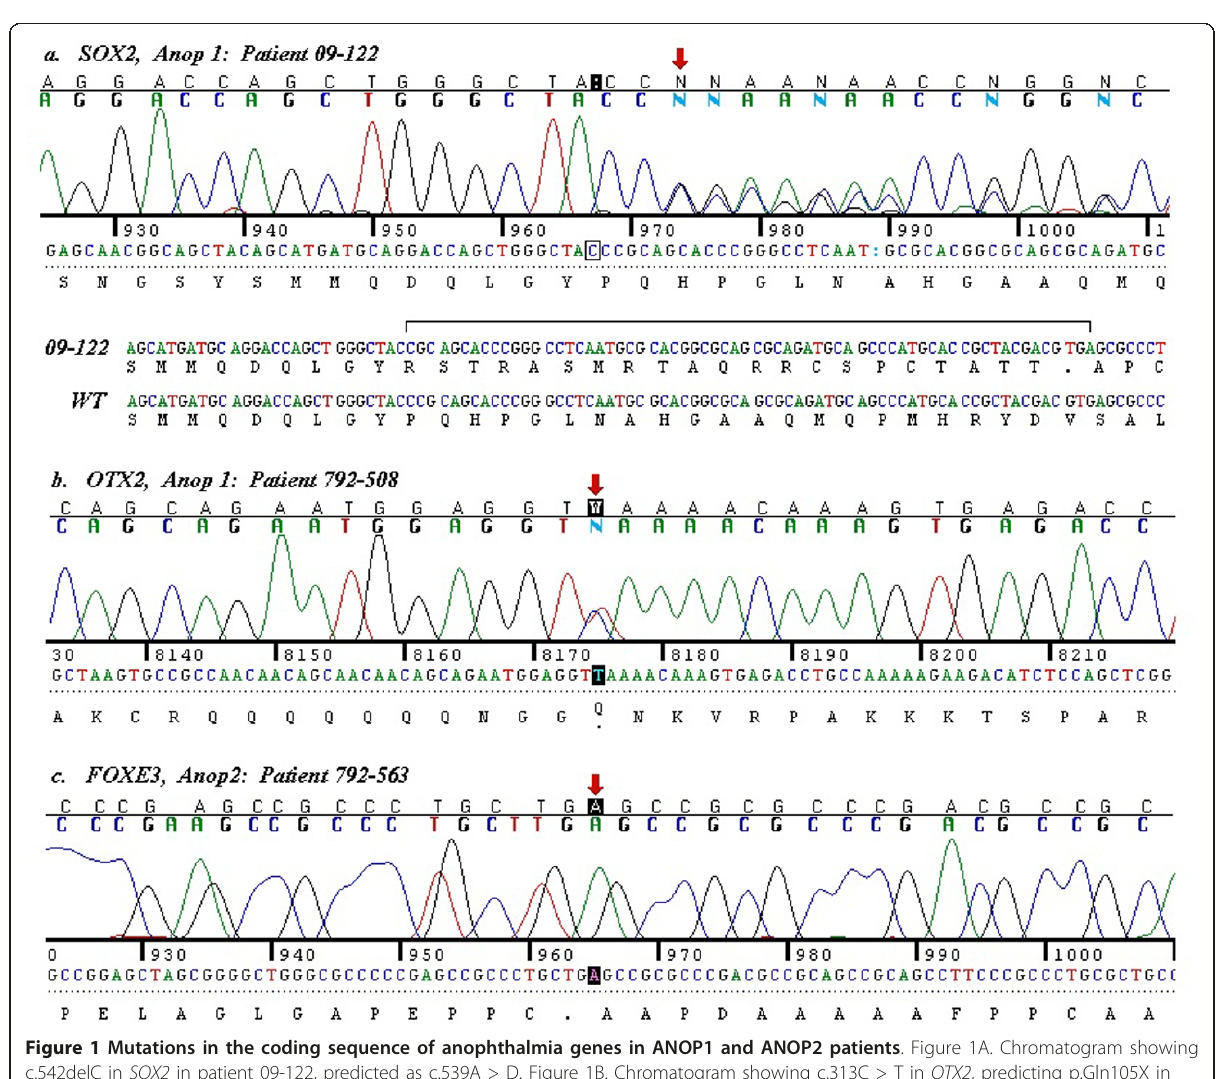
Figure 1 Mutations in the coding sequence of anophthalmia genes in ANOP1 and ANOP2 patients . Figure 1A. Chromatogram showing c.542delC in SOX2 in patient 09-122, predicted as c.539A > D. Figure 1B. Chromatogram showing c.313C > T in OTX2 , predicting p.Gln105X in patient 792-508. Figure 1C. Chromatogram showing c. 720C > A in FOXE3 , predicting p.Cys240X in patient